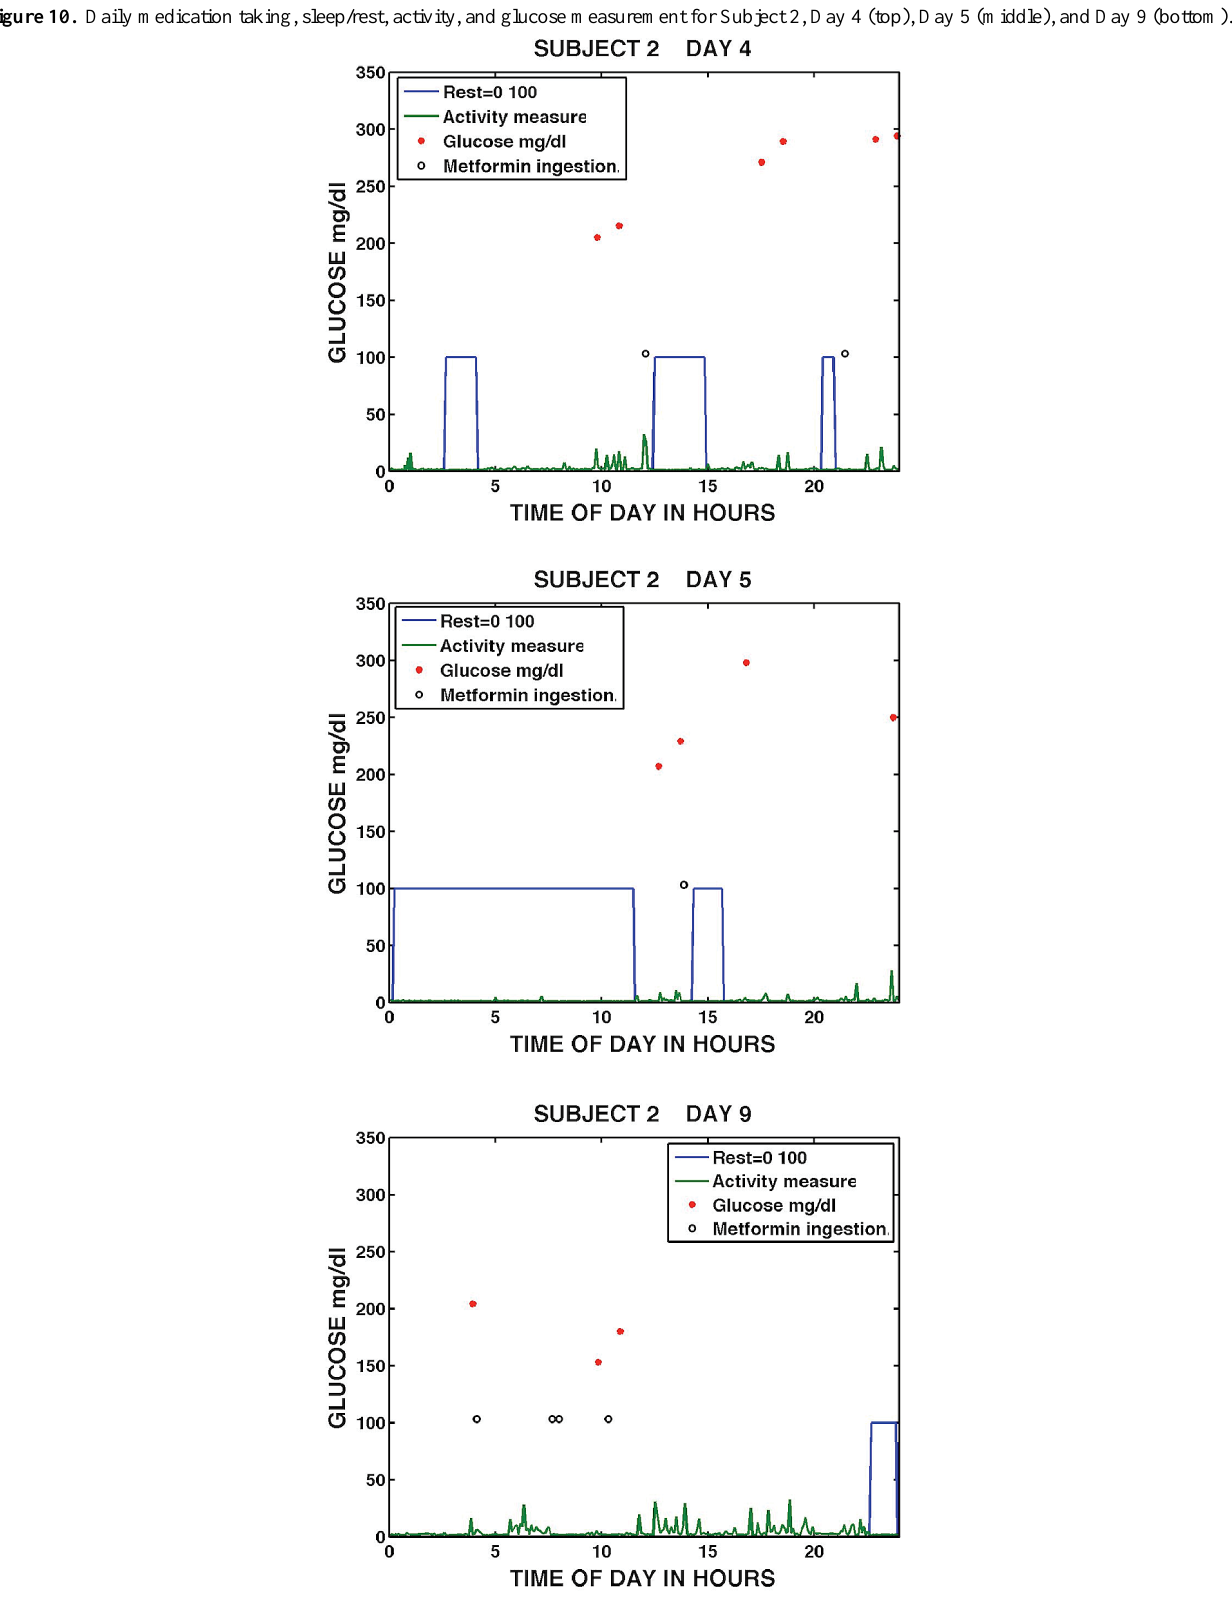
Figure 10. Daily medication taking, sleep/rest, activity, and glucose measurement for Subject 2, Day 4 (top), Day 5 (middle), and Day 9